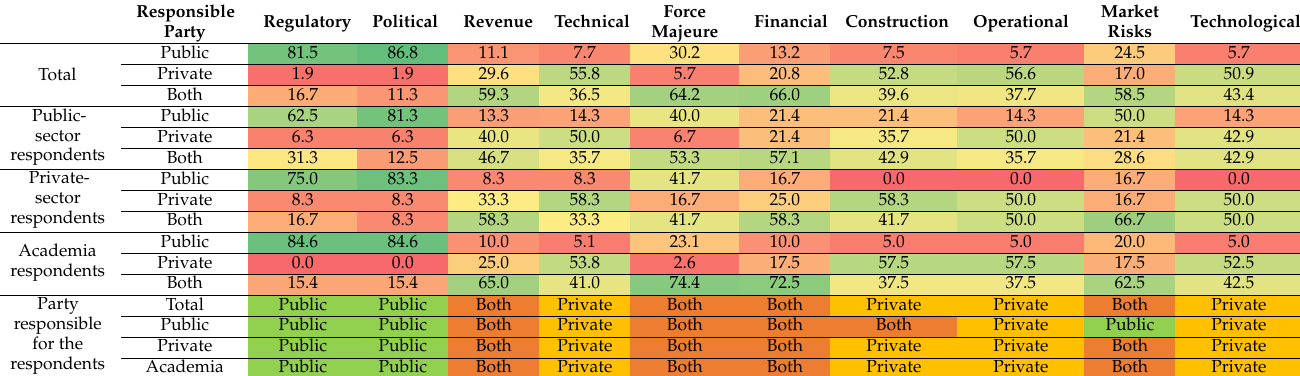
Table 3. Percentage of respondents assigning every barrier to the public sector, private sector or